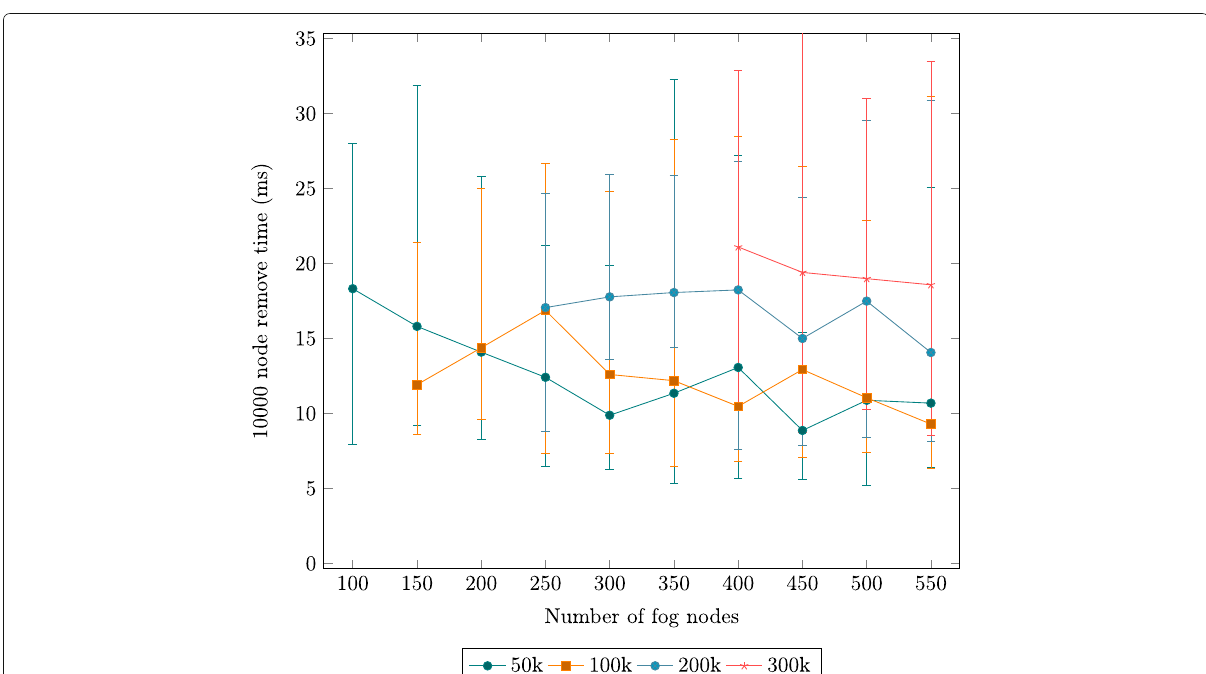
Fig. 5 Time required to remove 10000 edge nodes from service topologies of varying sizes. Legend numbers represent thousands of edge nodes